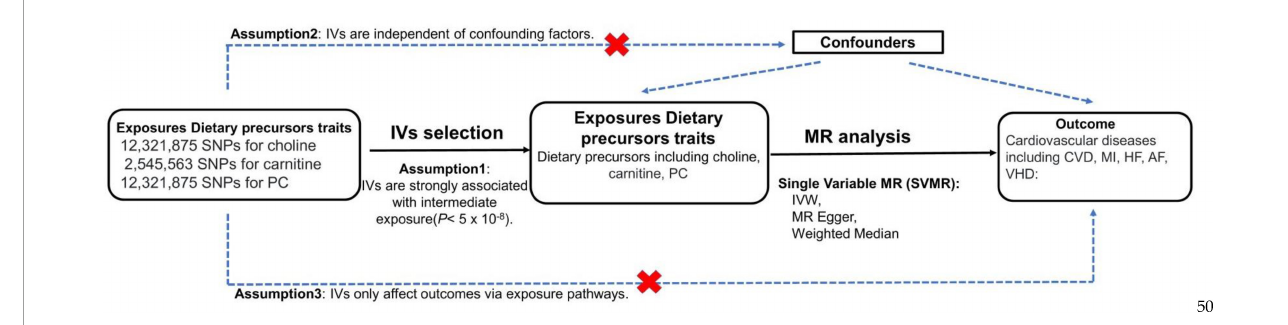
FIGURE1 MR study flow diagram to determine the causal effect of three dietary precursors on five cardiovascular diseases. Dashed lines indicate potential pleiotropic or direct causal effects between variables that may violate MR assumptions. PC, phosphatidylcholine; IV, instrumental variable; IVW, multiplicative random effects inverse variance weighted; CVD, cardiovascular disease; MI, myocardial infarction; HF, heart failure; AF, atrial fibrillation; VHD, valvular heart disease.